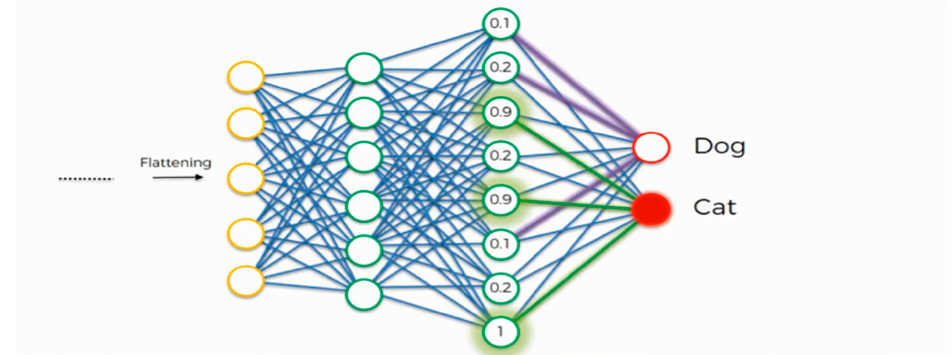
Figure 21. The process of the full connection [57].